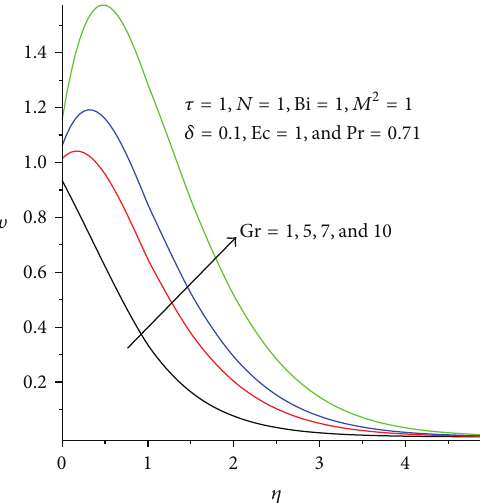
Figure 4: Velocity profiles with increasing